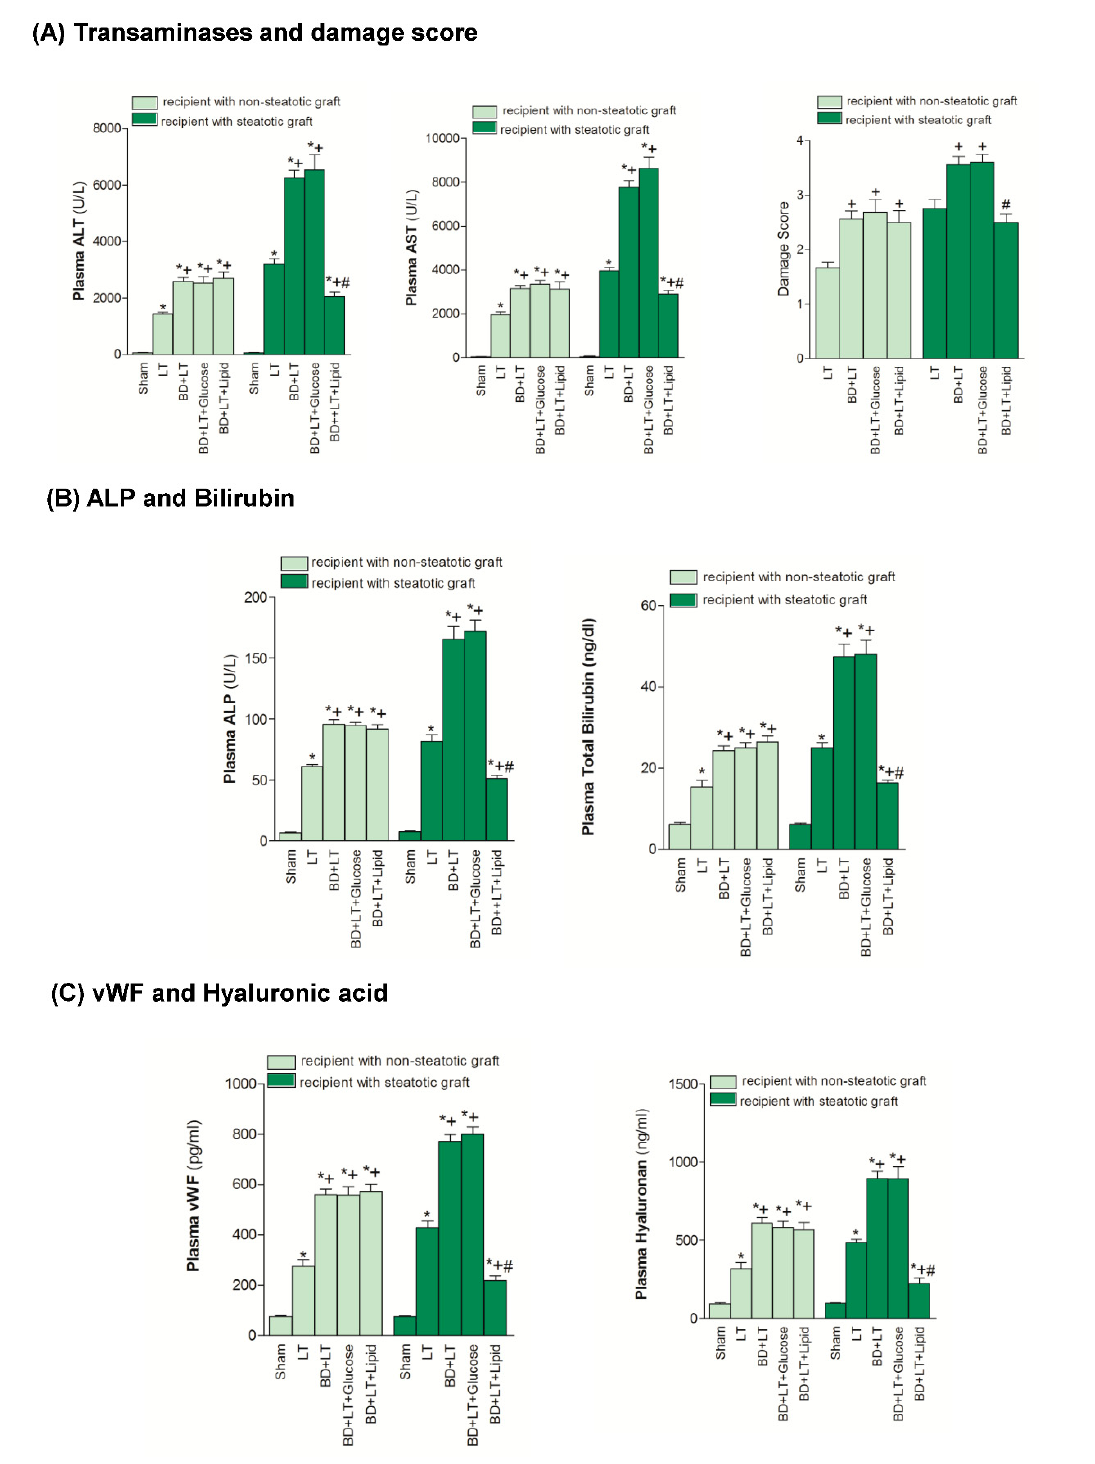
Figure 1. Effects of glucose and lipids on hepatic damage in steatotic and non-steatotic Liver transplantation (LT) in a genetic obesity experimental model. ( A ) AST and ALT in plasma, and damage score in liver. ( B ) alkaline phosphatase (ALP) and bilirubin in plasma. ( C ) von Willebrand factor (vWF) and hyaluronic acid in plasma. * p < 0.05 vs. Sham. + p < 0.05 vs. LT. # p < 0.05 vs. Brian death +Liver Transplantation (BD + LT). DBD, Donors after Brain